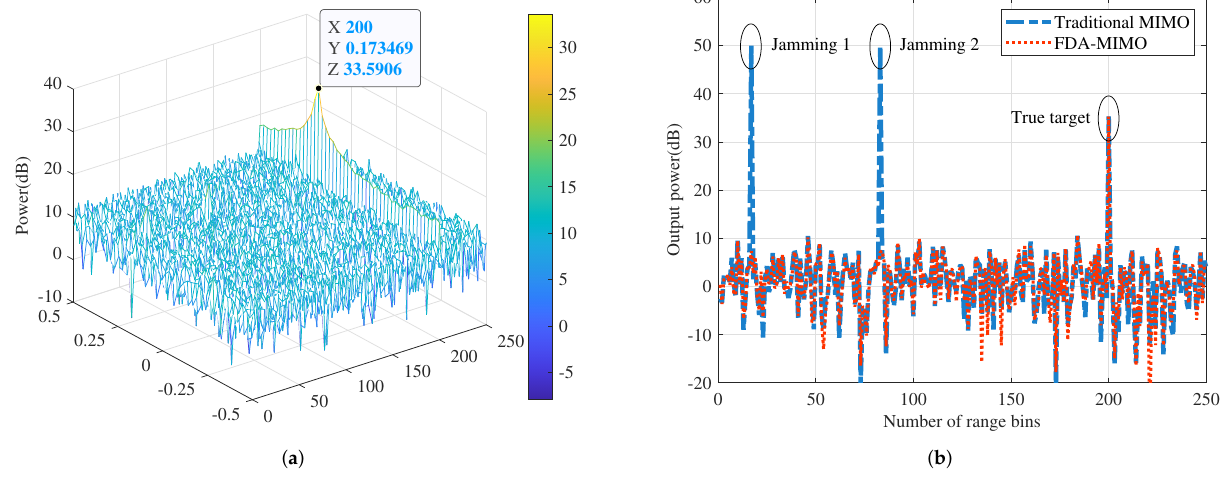
Figure 8. Output results of range-angle two dimensional RAB: ( a ) Range-Doppler filtering output results. ( b ) Output comparison of different radar